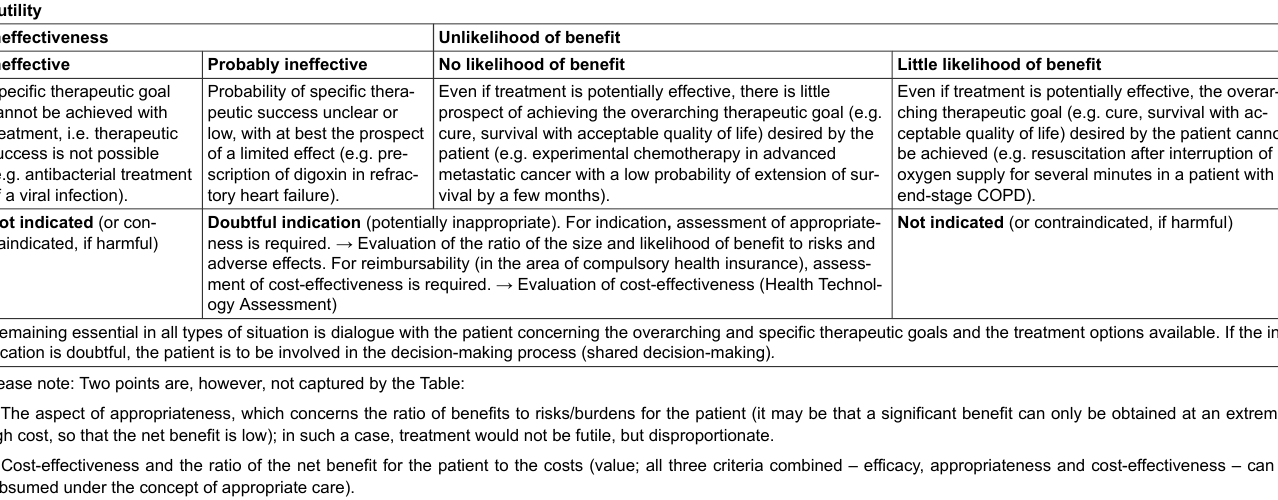
Table 1: Futility Ineffectiveness Unlikelihood of benefit Ineffective Probably ineffective No likelihood of benefit Little likelihood of benefit Specific therapeutic goal cannot be achieved with treatment, i.e. therapeutic success is not